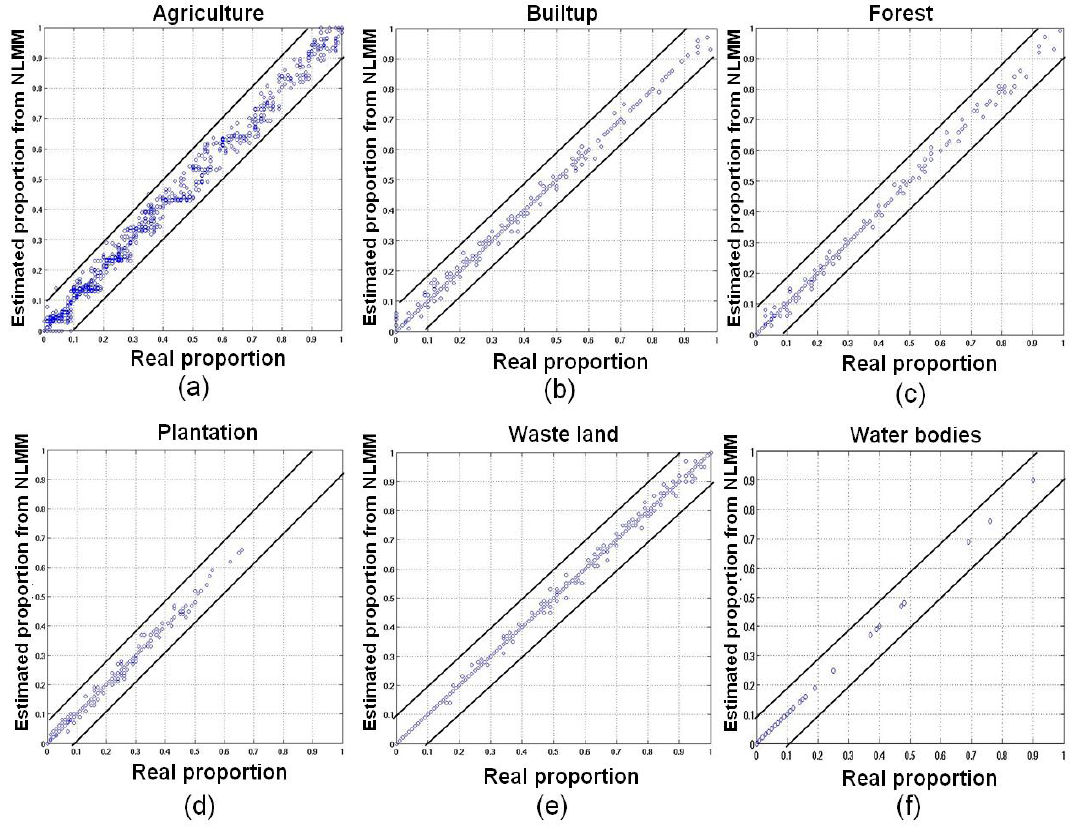
Figure 13. BDFs of MODIS test data from HMM. ( a ) agriculture; ( b ) built-up/settlement;